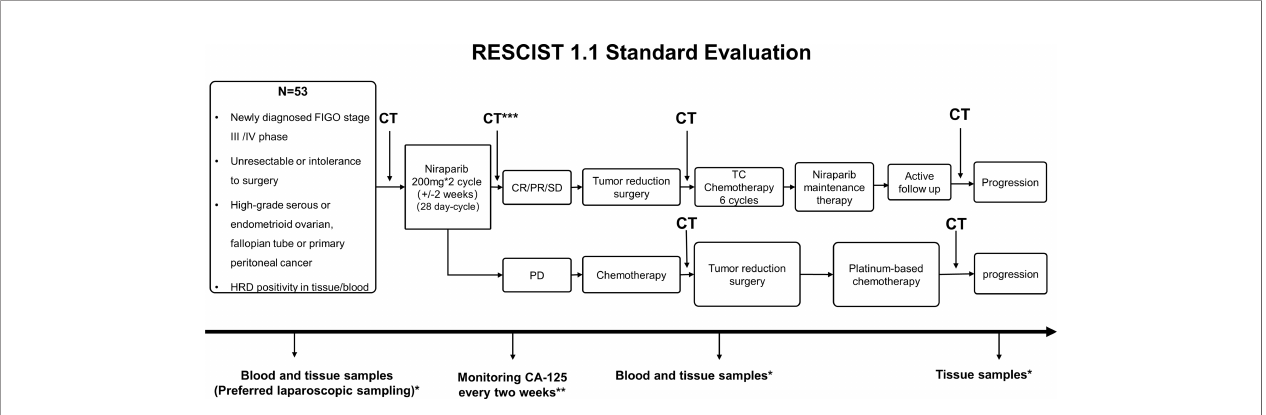
FIGURE 1 | Study Design. *Blood and tissue samples were collected at various stages i.e., before and during treatment, disease progression/recurrence, during surgery and post-operative chemotherapy and follow-up. **CA-125 was determined as per Gynecologic Cancer Intergroup Consensus (GCIC) guidelines. ***Abdominal CT or laparoscopy is recommended to classify objective remission status. CA-125, cancer antigen-125; CR, complete response; CT, computed tomography; FIGO, International Federation of Gynecology and Obstetrics; HRD, homologous recombination de fi ciency; NACT, neoadjuvant chemotherapy; N, number; PD, progressive disease; PR, partial response; RECIST, Response Evaluation Criteria in Solid Tumors; SD, stable disease; TC, Paclitaxel and carboplatin